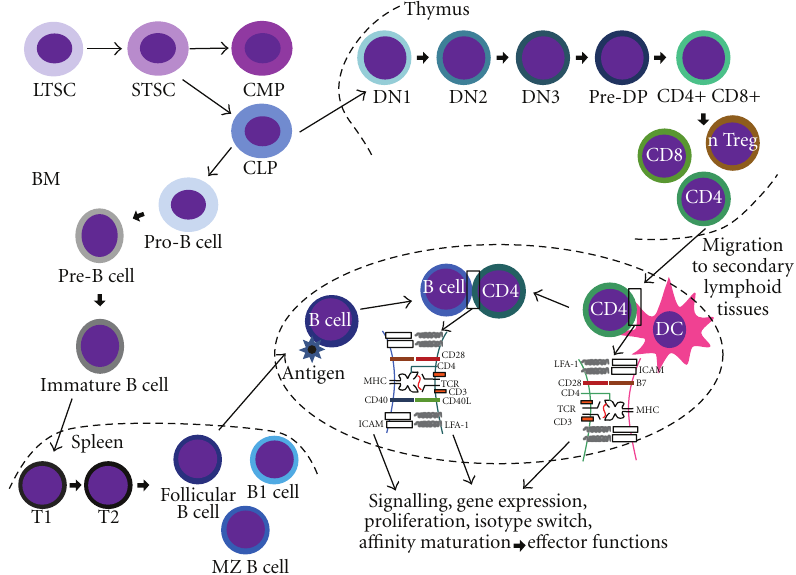
Figure 1: Schematic representation of lymphocyte development and activation. Development of lymphocytes takes place in primary lymphoid organs as the bone marrow (BM) and the thymus. Long-term hematopoietic stem cells (LTSCs) generate short-term hematopoietic stem cells (STSCs), which in turn generate common myeloid and lymphoid progenitors (CMP and CLP, resp.,). T cell progenitor, migrate to the thymus, where they undergo maturation through stages known as double negative (DN), representing CD4 − CD8 − cells, double positive, and finally mature CD4 + or CD8 + T cells. Immature B cells leave the bone marrow to finish their development in the spleen, where they progress through transitional stages 1 and 2 (T1 and T2) to generate mantle-zone B cells (MZ B cells), follicular B cells, or B1 cells. All mature lymphocytes circulate through secondary lymphoid organs, where they are exposed to antigens, directly or through antigen presenting cells. After the first stimulation by antigens, B and T cells migrate towards each other to interact in a process that will determine B cell antibody production and T cell proliferation and further activation. The immunological synapses are represented between a dendritic cell and a naive T cell and between primed B and T cells. In detail, one may observe molecules present in immunological